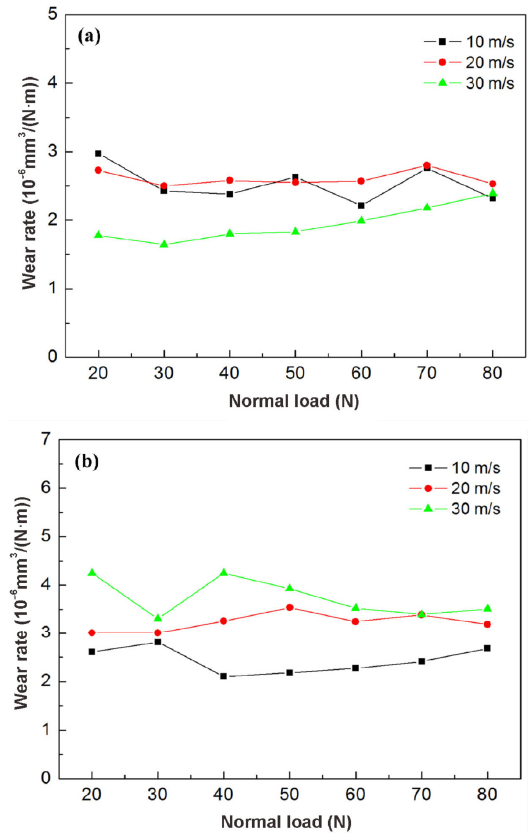
Fig. 7 Wear rates of (a) Ti 2 AlC and (b) Ti 2 AlSn 0.2 C sliding against low-carbon steel at different sliding speeds as a function of normal